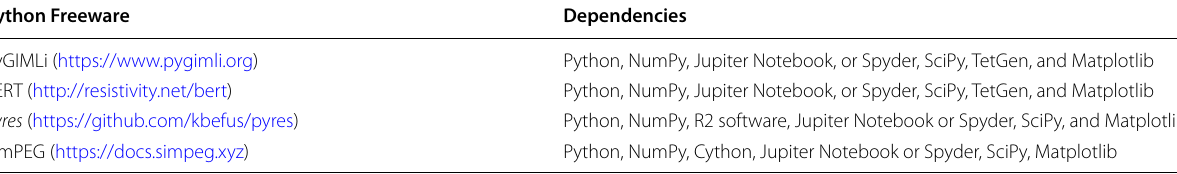
Table 1 Pre‑requests for Python‑based inversion freeware Python Freeware Dependencies PyGIMLi (https:// www. pygim li. org) Python, NumPy, Jupiter Notebook, or Spyder, SciPy, TetGen, and Matplotlib BERT (http:// resis tivity. net/ bert) Python, NumPy, Jupiter Notebook, or Spyder, SciPy, TetGen, and Matplotlib pyres (https:// github. com/ kbefus/ pyres) Python, NumPy, R2 software, Jupiter Notebook or Spyder, SciPy, and Matplotlib SimPEG (https:// docs. simpeg.